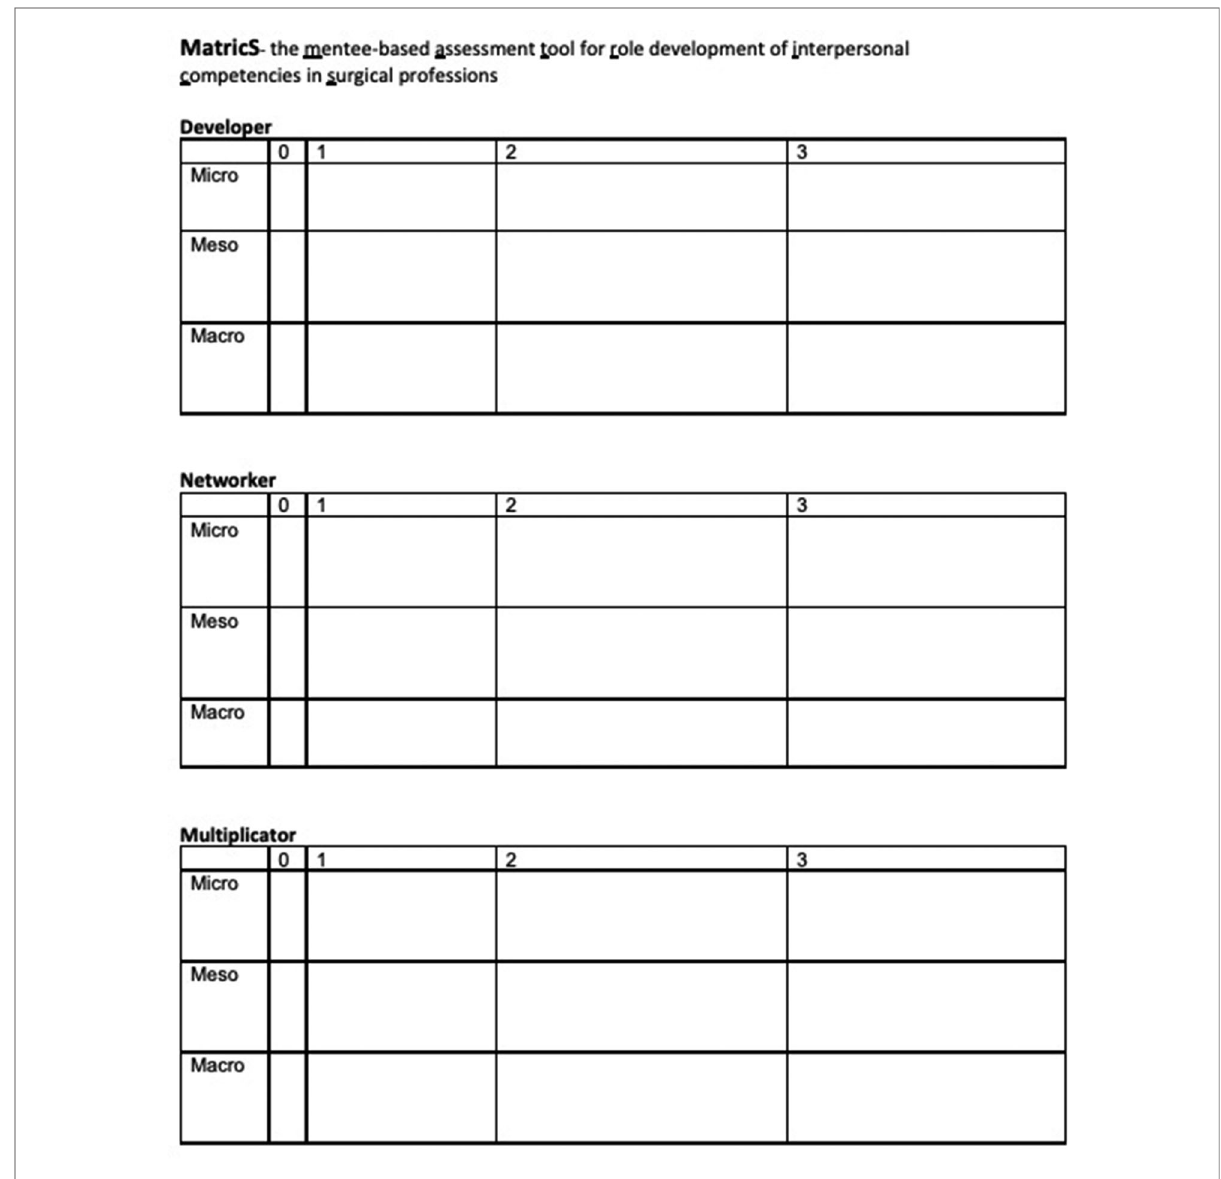
FIGURE 1 Assessment tool for role development of interpersonal competencies in surgical professions. Using the Learning Objective-based role matrix, mentees and mentors can rate the mentee ’ s competencies on a scale from 0 to 3: 0 indicates no knowledge; 1 indicated basic skills and abilities; 2 indicates knowledge, skills, and abilities consistent with the core learning objectives of the Urology Roadmap mentoring program; 3 indicated knowledge, skills, and abilities corresponding to the core learning objectives and extended learning objectives of the Urology Roadmap mentoring program. Filling the corresponding cell of the matrix with an example of the individual competency is encouraged, but not